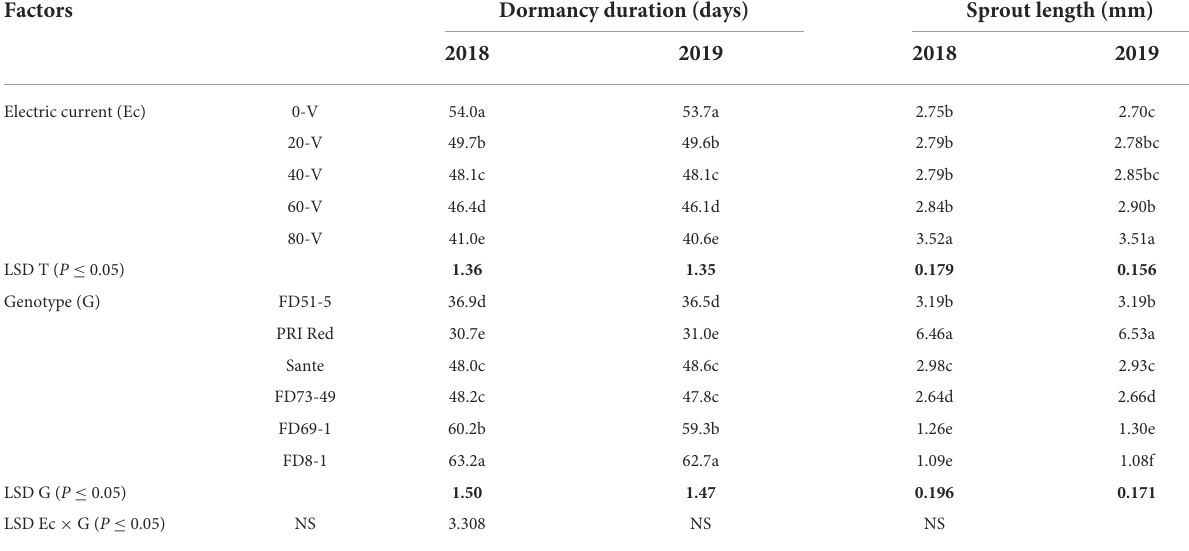
TABLE 3A Mean comparison of dormancy duration and sprout length of six genotypes potato tubers during 2018–2019 underwent direct electric current. Factors Dormancy duration (days) Sprout length